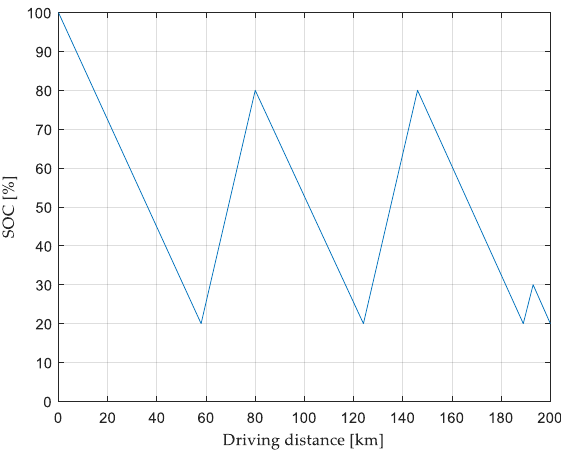
Figure 11. SOC of battery in electric vehicle after optimization, distance = 200 km.